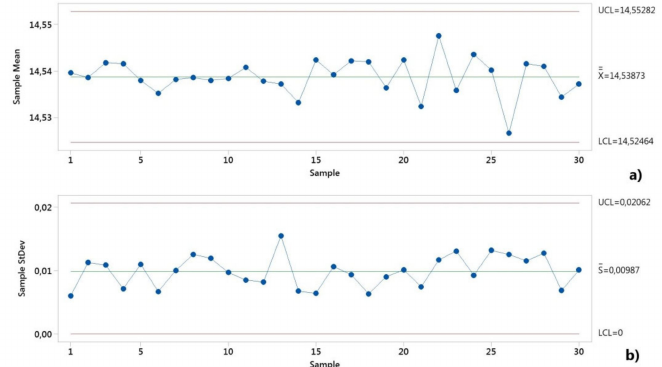
Figure 11. The control charts for the long-term capability study of diameter dimension (D): ( a ) mean data; ( b ) standard deviation